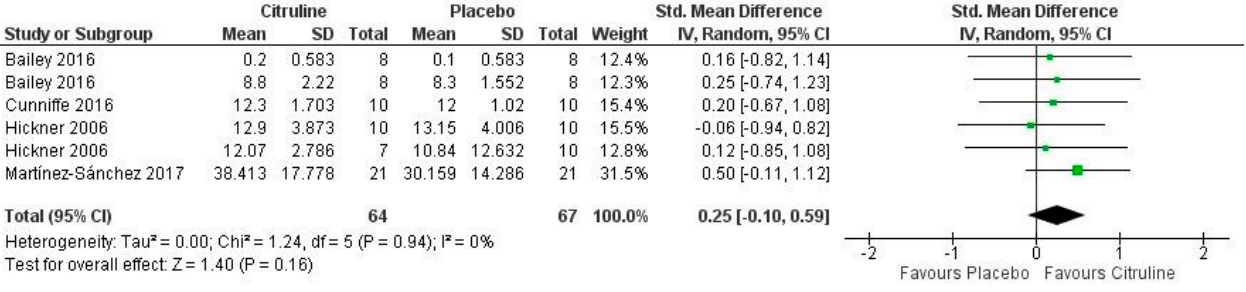
Figure 8. Forest plot comparative study of the effects of Cit supplementation on lactate [43,48,57,59].